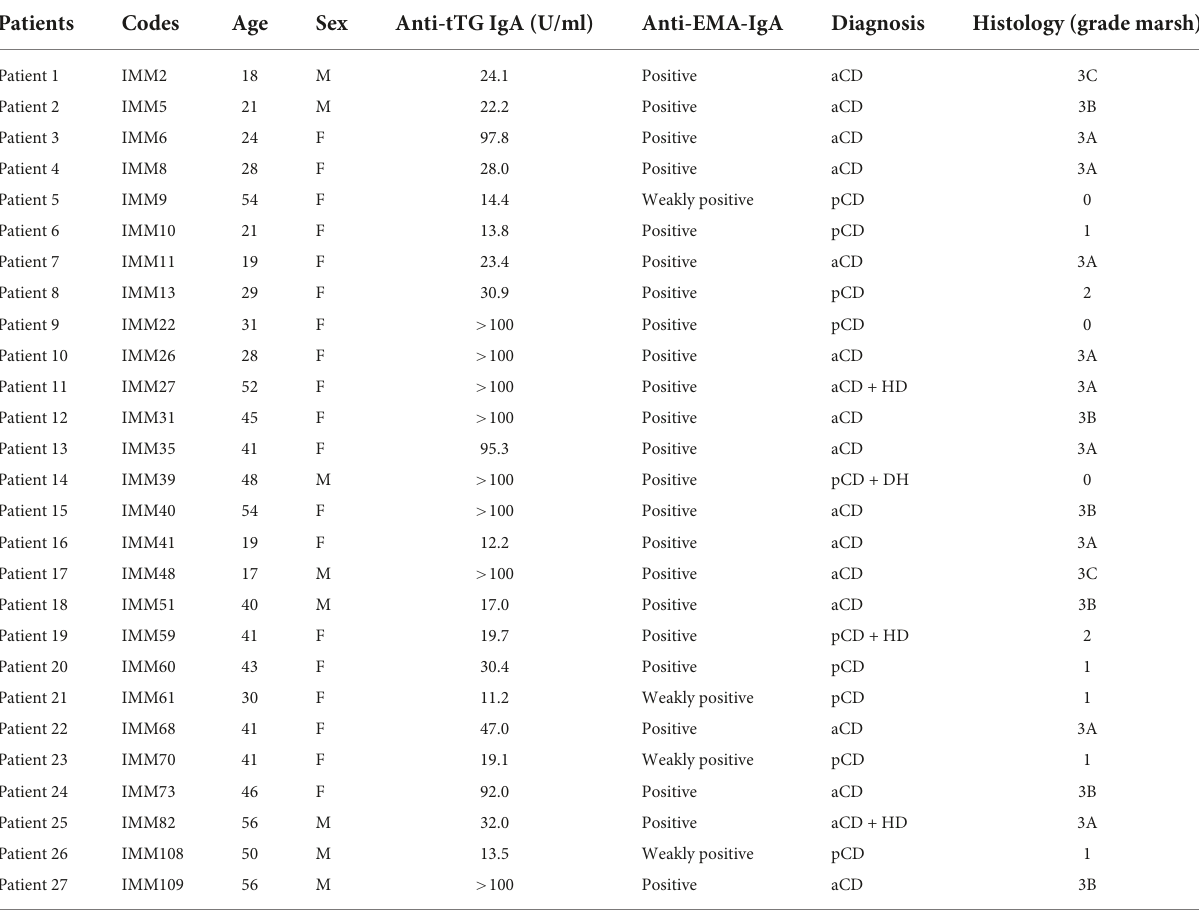
TABLE 1 Patients’ clinical parameters.